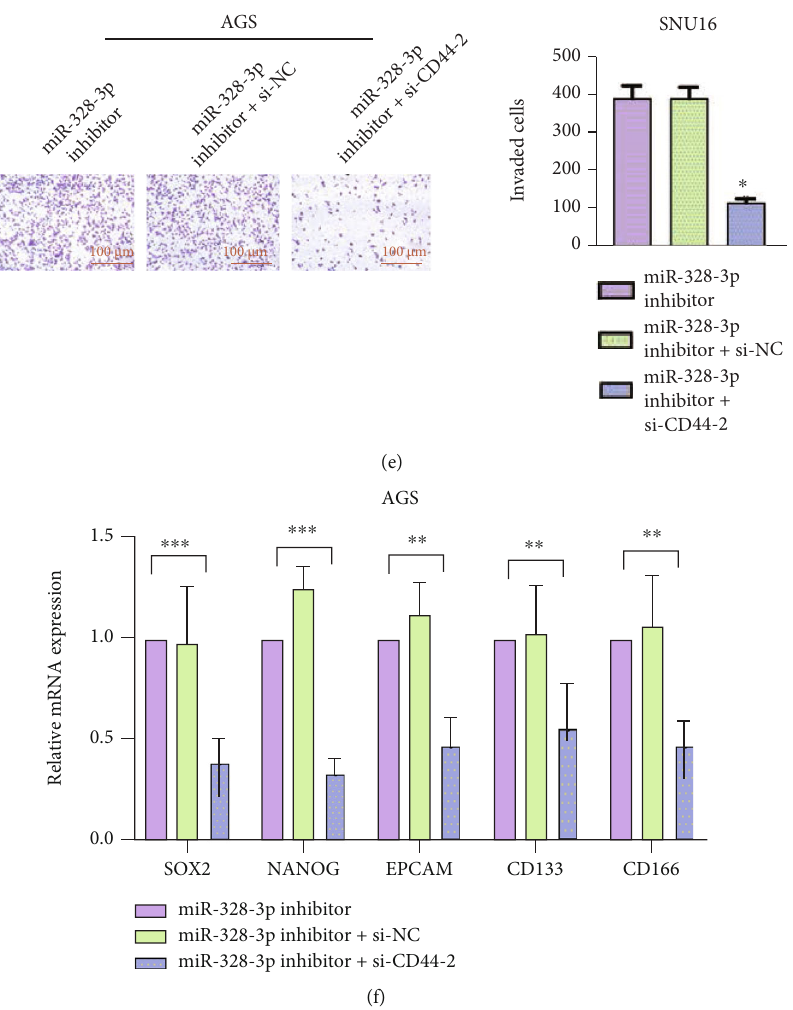
Figure 4: miR-328-3p worked as a cancer suppressor in STAD via targeting CD44. To further indicate whether miR-328-3p regulated the behaviors of STAD cells in a CD44-dependent manner, AGS cells were cotransfected with miR-328-3p inhibitors and si-CD44. (a) qRT-PCR and Western blot were utilized to detect the transfection e ffi ciency of CD44 knockdown. (b) CCK-8 assay was used to assess the proliferation rate of AGS cells. (c) Western blot assay was used to detect the expression levels of apoptosis-related proteins. (d, e) The migration and invasion of AGS cells were assessed with (d) wound healing and (e) Transwell assays. (f) The expression levels of SOX2, NANOG, EPCAM, CD133, and CD166 were determined by qRT-PCR. Scale bar = 100 μ m. All experiments were performed in triplicate. ∗ P < 0 : 05 , ∗∗ P < 0 : 01 , and ∗∗∗ P < 0 : 001